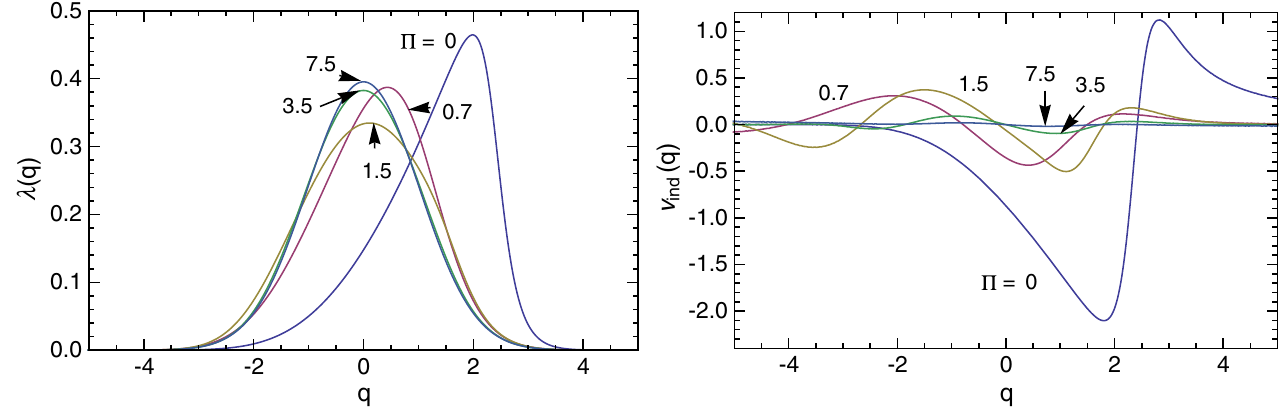
FIG. 4. Haı¨ssinski solution at threshold and wake induced voltage for shielded CSR, for the cases (cid:1) ¼ 0 : 0 ; 0 : 7 ; 1 : 5 ; 3 : 5 ; 7 : 5 . Note that the bunch head is to the right.